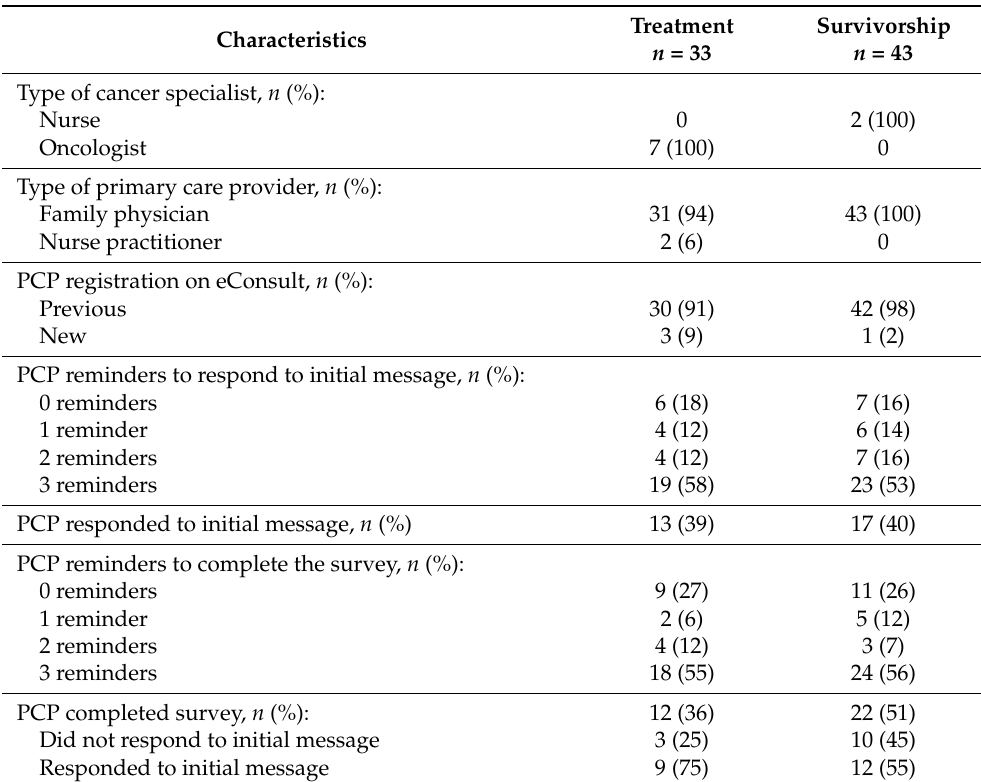
Table 1. Participant